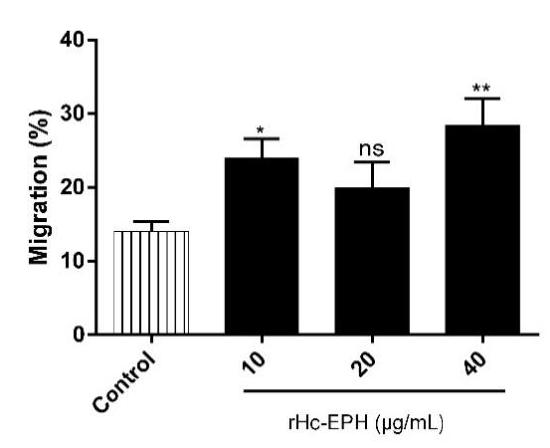
Figure 5. Effects of rHcEPH on PBMCs migration. PBMCs were treated with serial concentrations of rHcEPH and PBS. The migration percentage was determined randomly, and the data is denoted as mean ± SEM of three independent experiments (* p < 0.05, ** p < 0.01 and ns: no significant difference).